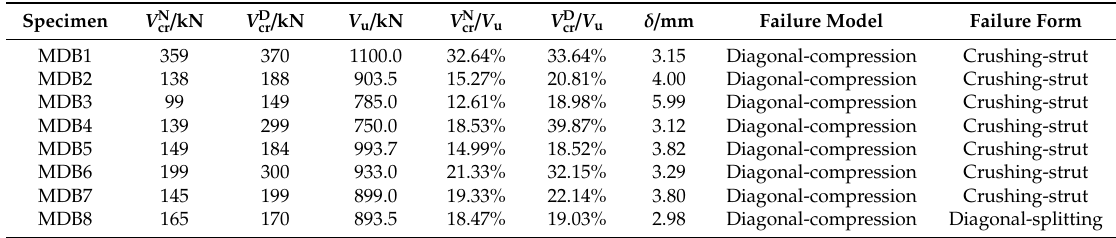
Table 4. Main test results of MDB series deep beam